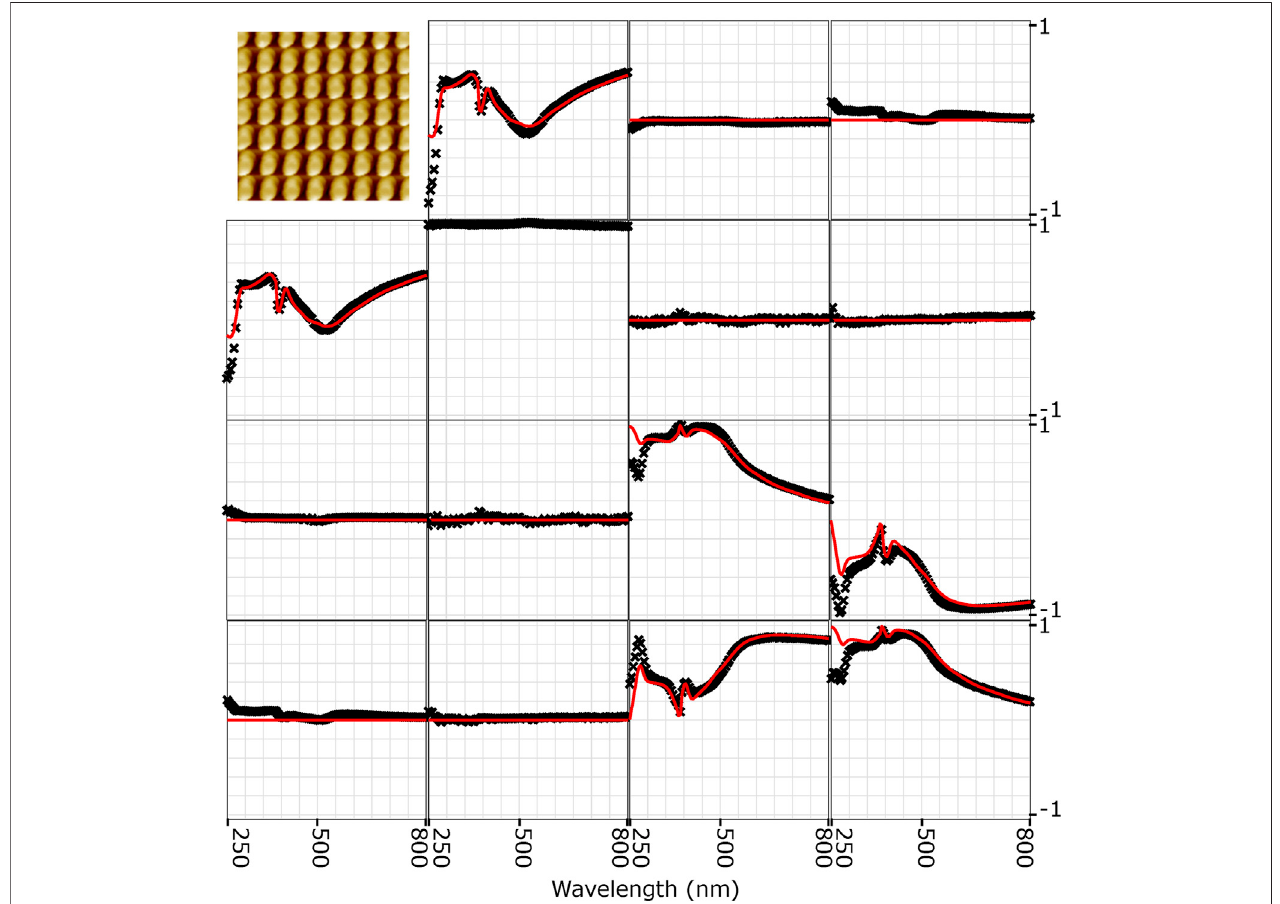
FIGURE5| ExperimentalMuellerellipsometrymeasurements(black crosses)and fi ttedMuellerellipsometryresults(redlines).TheupperleftcornershowsanAFM picture of the structure. A strong agreement between model and fi t are found within all Mueller matrix elements for wavelengths > 300 nm. All the anisotropic Mueller matrix elements: m 13 , m 14 , m 23 , m 24 , m 31 , m 32 , m 41 and m 42 have been set to zero in the